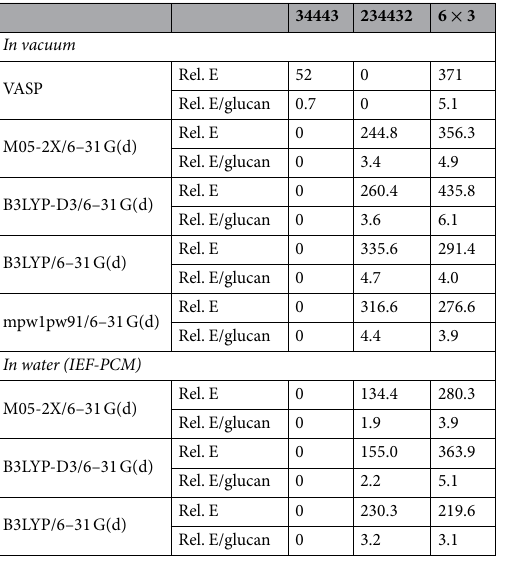
Table 3. Calculated energies of 6 × 3, 234432 and 34443 models with various methods (kJ/mol). Rel. E: relative potential energy, Rel. E/glucan: relative potential energy normalized on a per glucan unit base. The lowest energy obtained from each method was set to 0 kJ/mol.